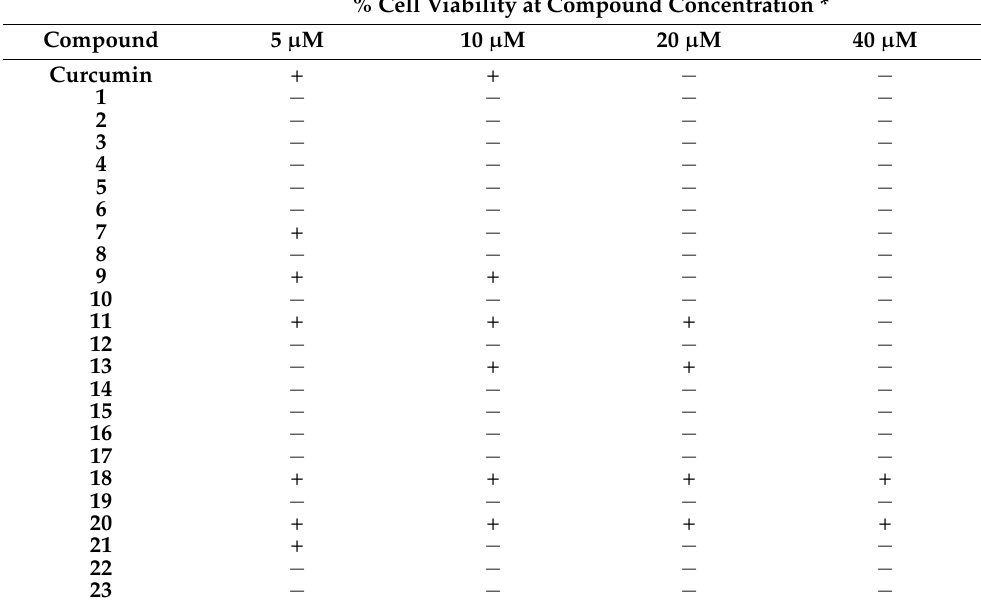
Table 5. Neuroprotection activity in SH-SY5Y cells under oxidative stress conditions (H 2 O 2 250 µ M).